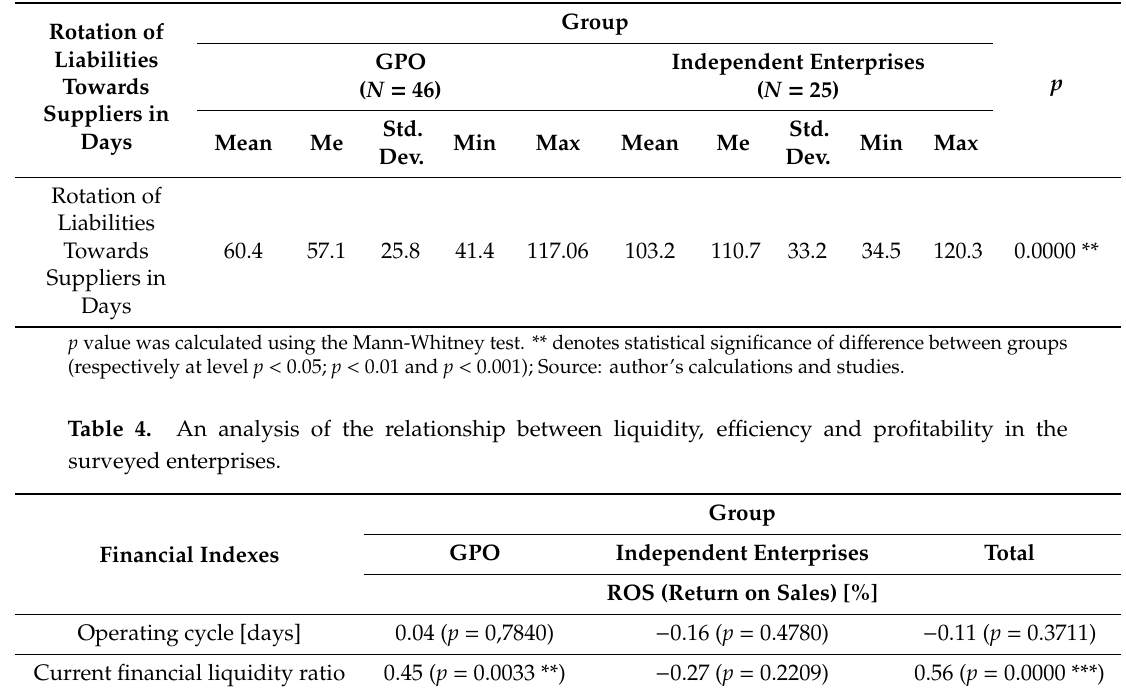
Table 3. Rotation of liabilities to suppliers for the enterprises analysed (2016–2019).